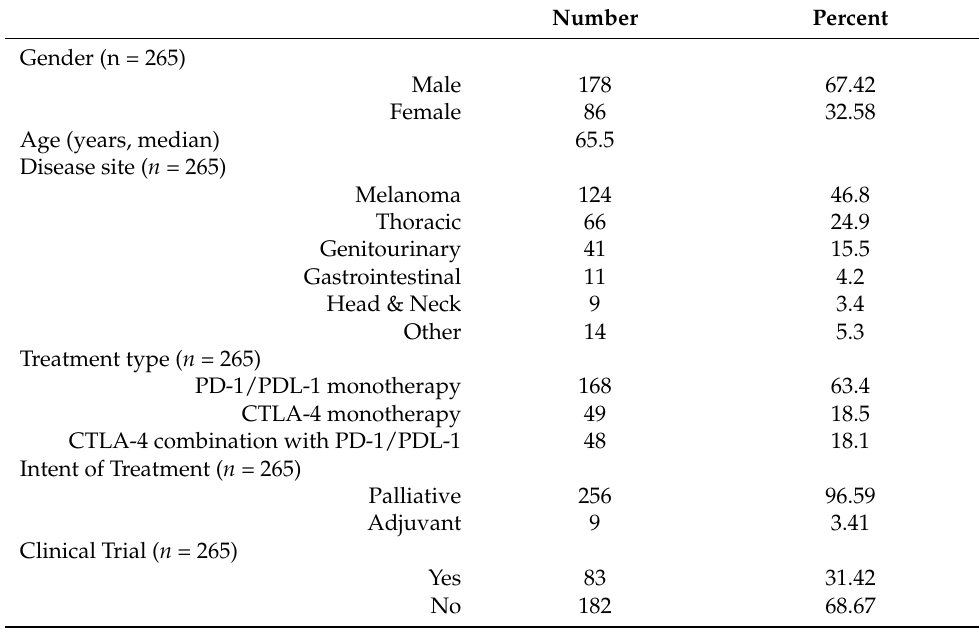
Table 1. Demographics of patients receiving ICI who had cortisol levels